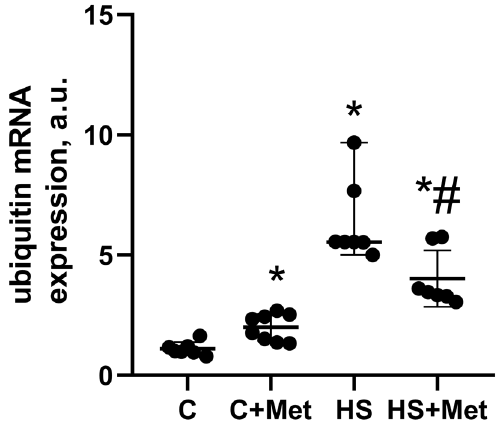
Figure 12. Effect of metformin pre-treatment on ubiquitin mRNA expression in rat soleus muscle. C, vivarium control, C+Met, vivarium control + metformin pre-treatment, HS, 7-day hindlimb suspension, HS+Met, metformin pre-treatment + 7-day hindlimb suspension. Scatter dot plot indicates median values, and the whiskers represent minimum and maximum values; n = 7–8/group. *: p < 0.05 vs. C, #: p < 0.05 vs. HS.